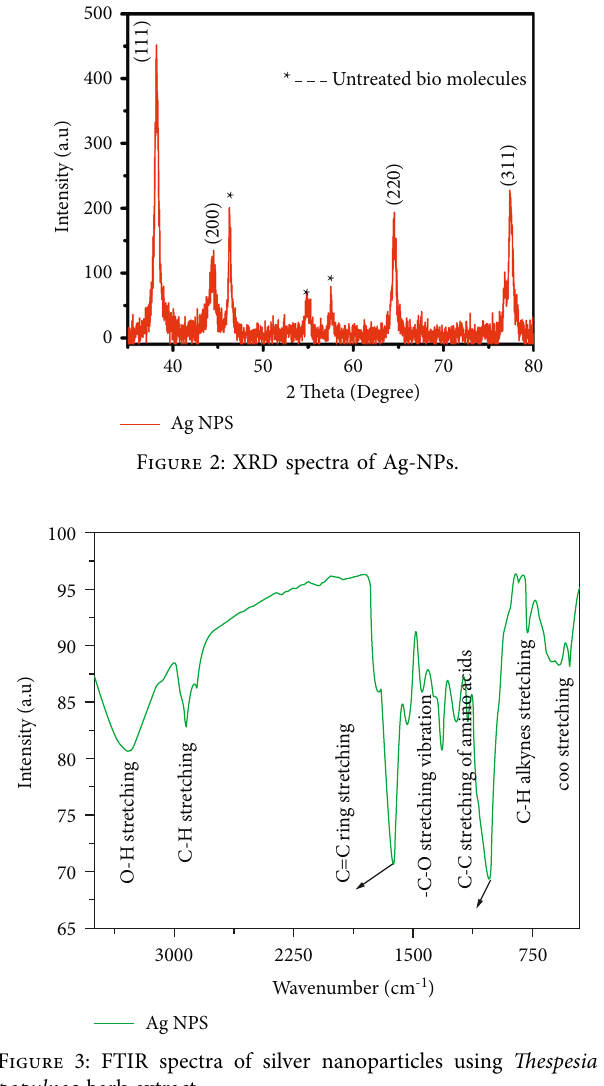
Figure 5: UV-visible absorbance spectra after 4 months.